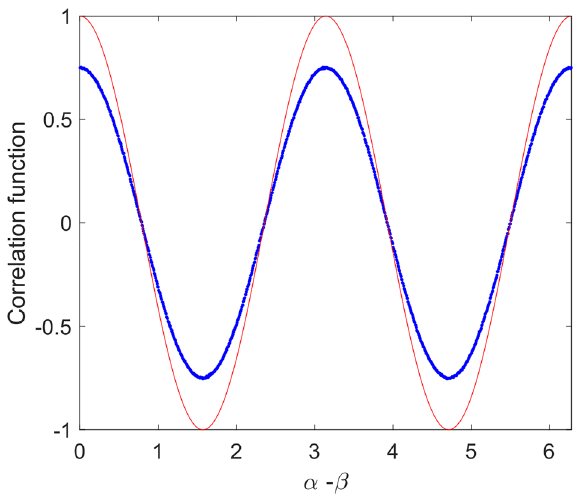
Figure 6. Simulation result of correlation function versus angle difference of polarizers based on relations (21) and (22) (dot line-blue) compared to quantum mechanics prediction (solid